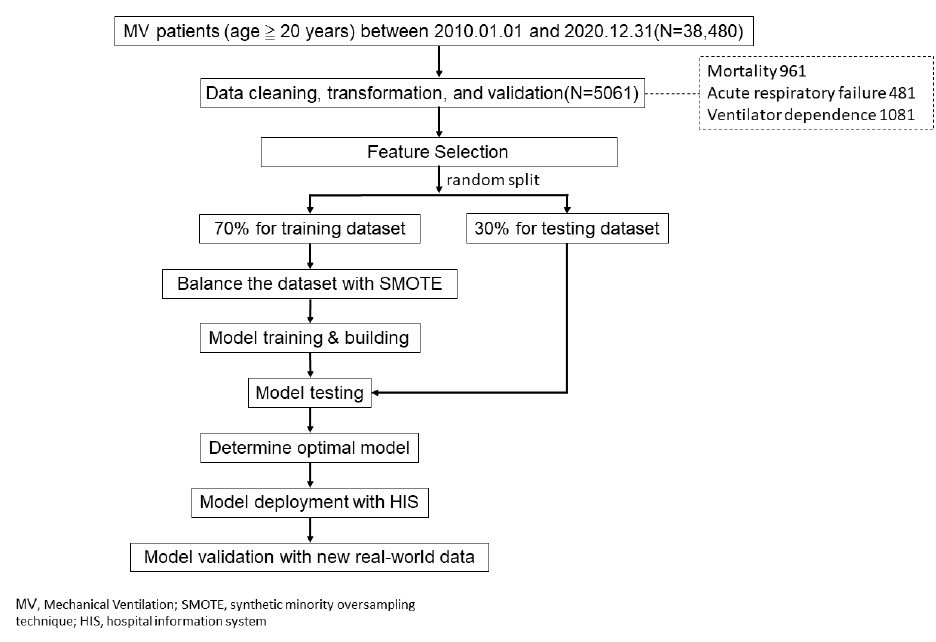
Figure 1. Research flow.